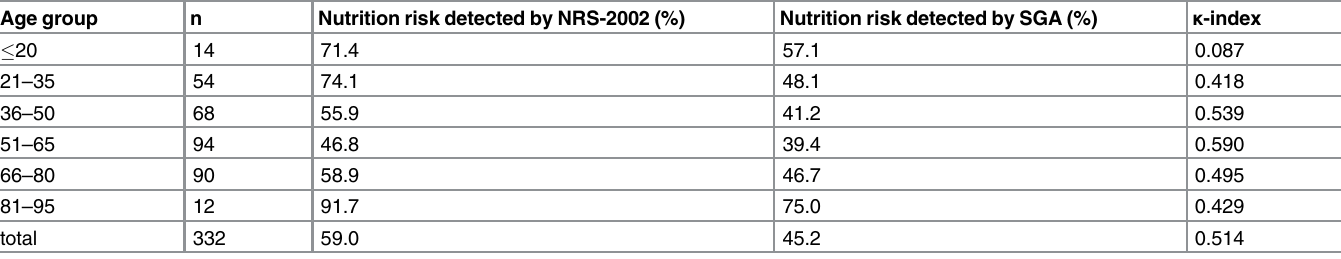
(Table 3). There was little difference between the LOS predicting capacity of NRS-2002 (R square = 0.130) and SGA (R square = 0.140). Inclusion of the interaction between the screening tool (NRS-2002 or SGA) and categorized age did not improve the model for the outcomes of LOS and cost (Table 4). The results of the area under ROC curve analysis showed that the complication and death predicting capacity of NRS-2002 and SGA was generally better than random guessing (Fig 2, Table 5). NRS-2002 and SGA had poor predictive capacity for infectious complications (0.60 –